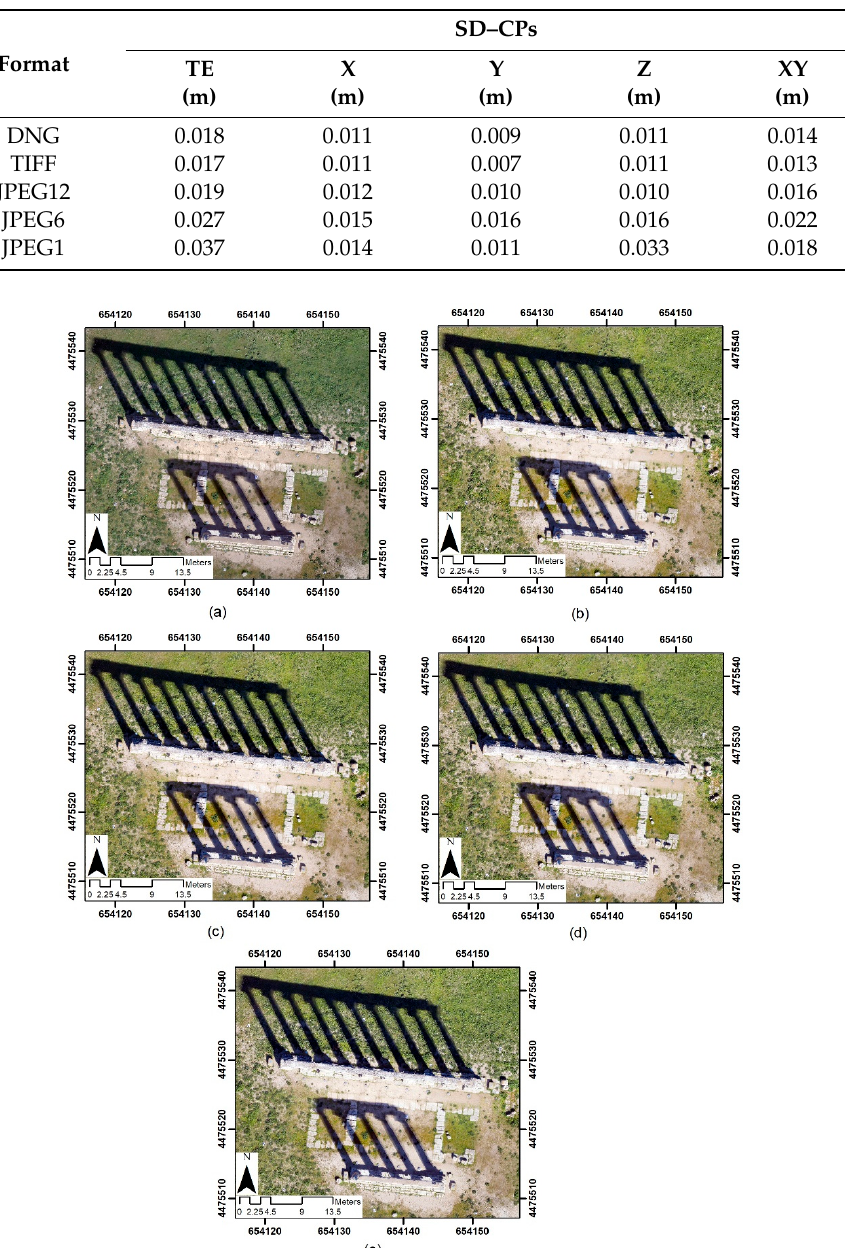
Table 11. Evaluation of the accuracy using 3DF Zephir on CPs and number of tie points—Test site 3.